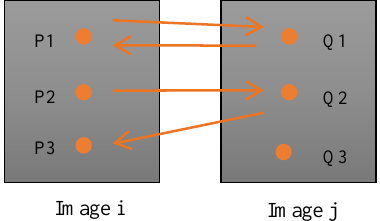
Figure 2. Forward/backward consistency check for an